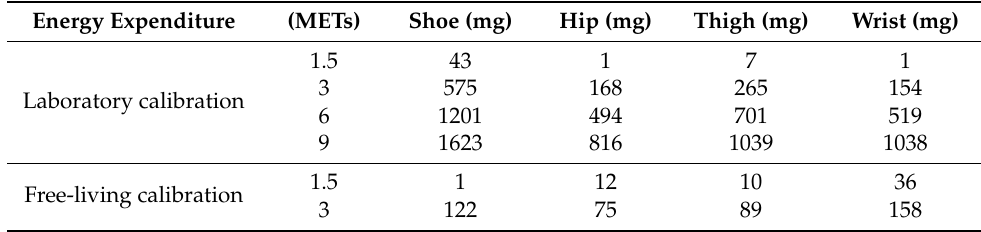
Figure 1. Calibrations between accelerometer output and energy expenditure (METs) in laboratory and free living based on smoothing splines. Table 3. Accelerometer cut-points for energy